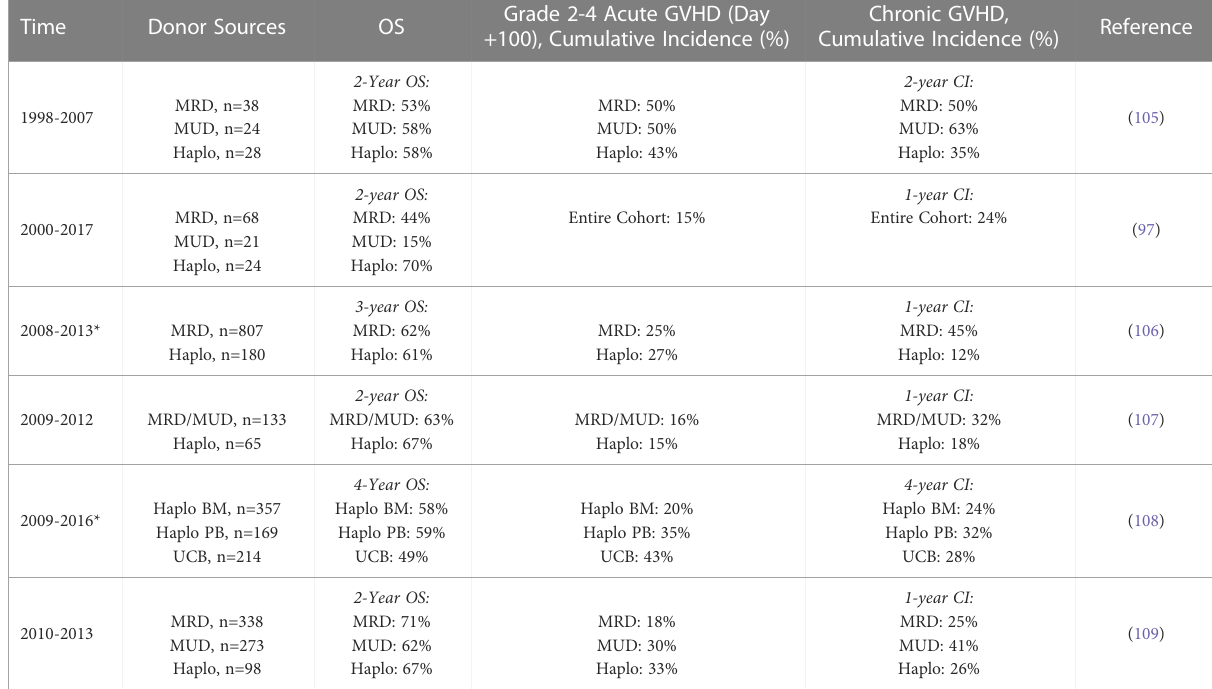
TABLE 2 Donor selection for allogenic hematopoietic cell transplant in R/R cHL. Time Donor Sources OS